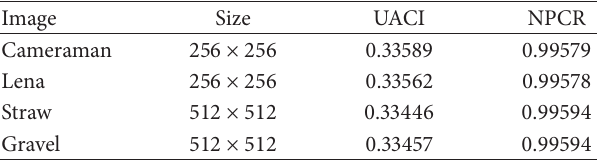
Table 2: NPCR and UACI of two encrypted images with one-bit difference.